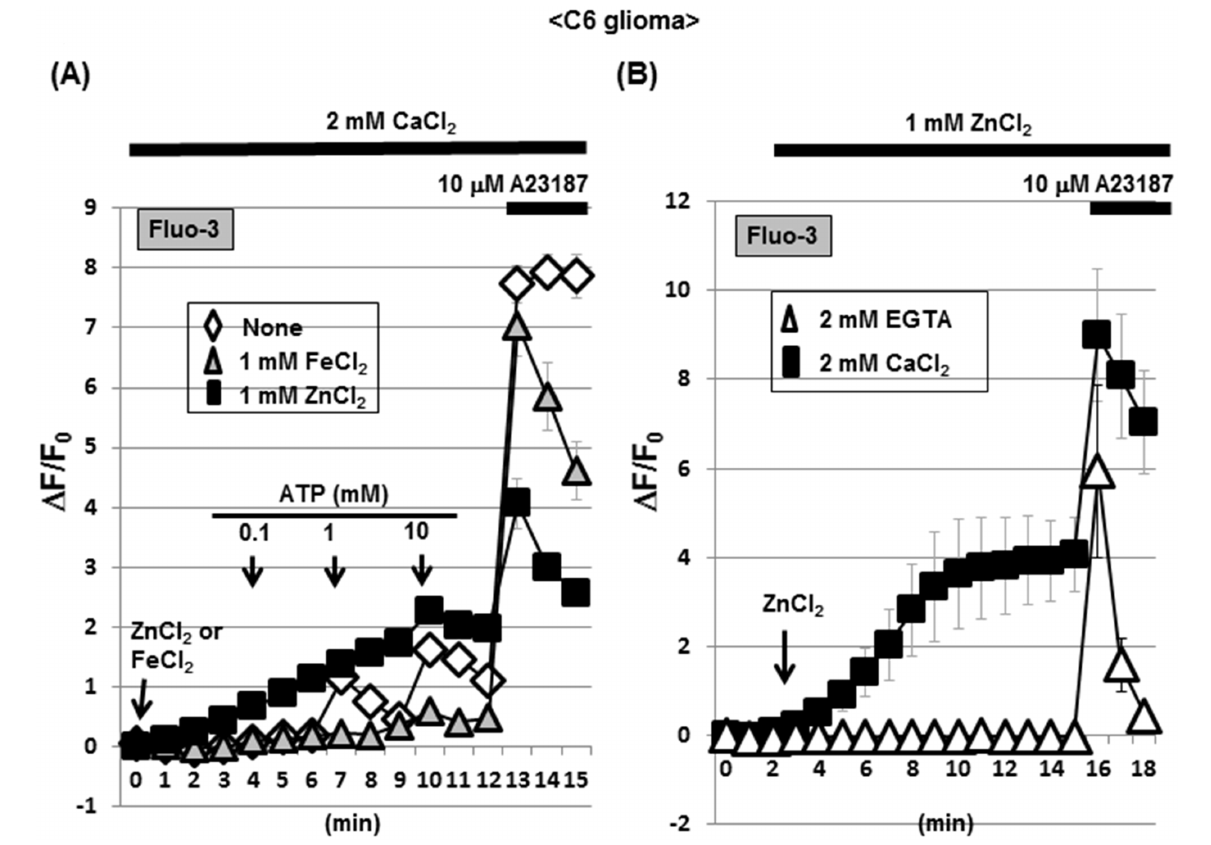
Fig 3. A selective increase by ZnCl 2 in Fluo-3 fluorescence in C6 glioma cells. (A) Cells were loaded with Fluo-3 in the presence of CaCl 2 , followed by determination of the fluorescence intensity in either the presence or absence of ZnCl 2 and FeCl 2 every 1 min. Cells were exposed to ATP at different concentrations during the determination of fluorescence. (B) Cells were loaded with Fluo-3 in the presence of either EGTA or CaCl 2 , followed by determination of the fluorescence intensity in the presence of ZnCl 2 every 1 min. Values are the mean ± S.E. of the rate of fluorescence change in 3 different